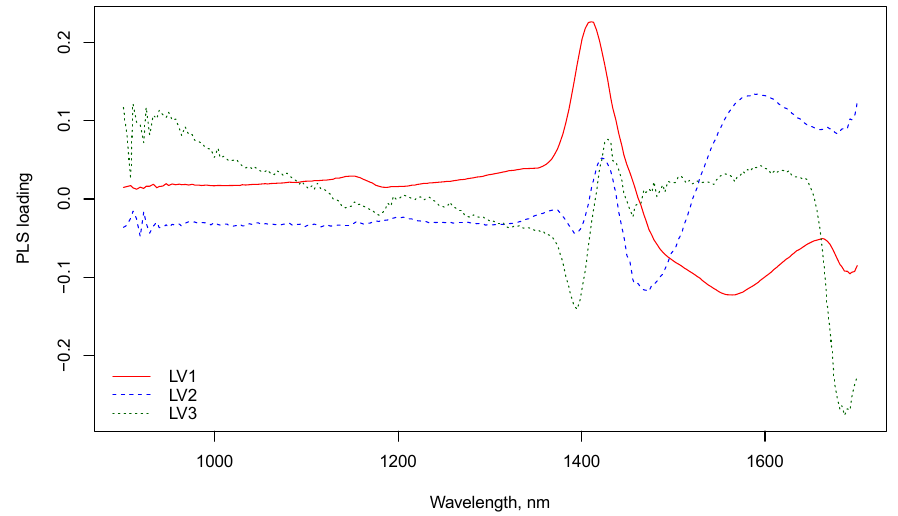
Figure 4. Loading values of LV1–3 for the PLSR model in 900–1700 nm.